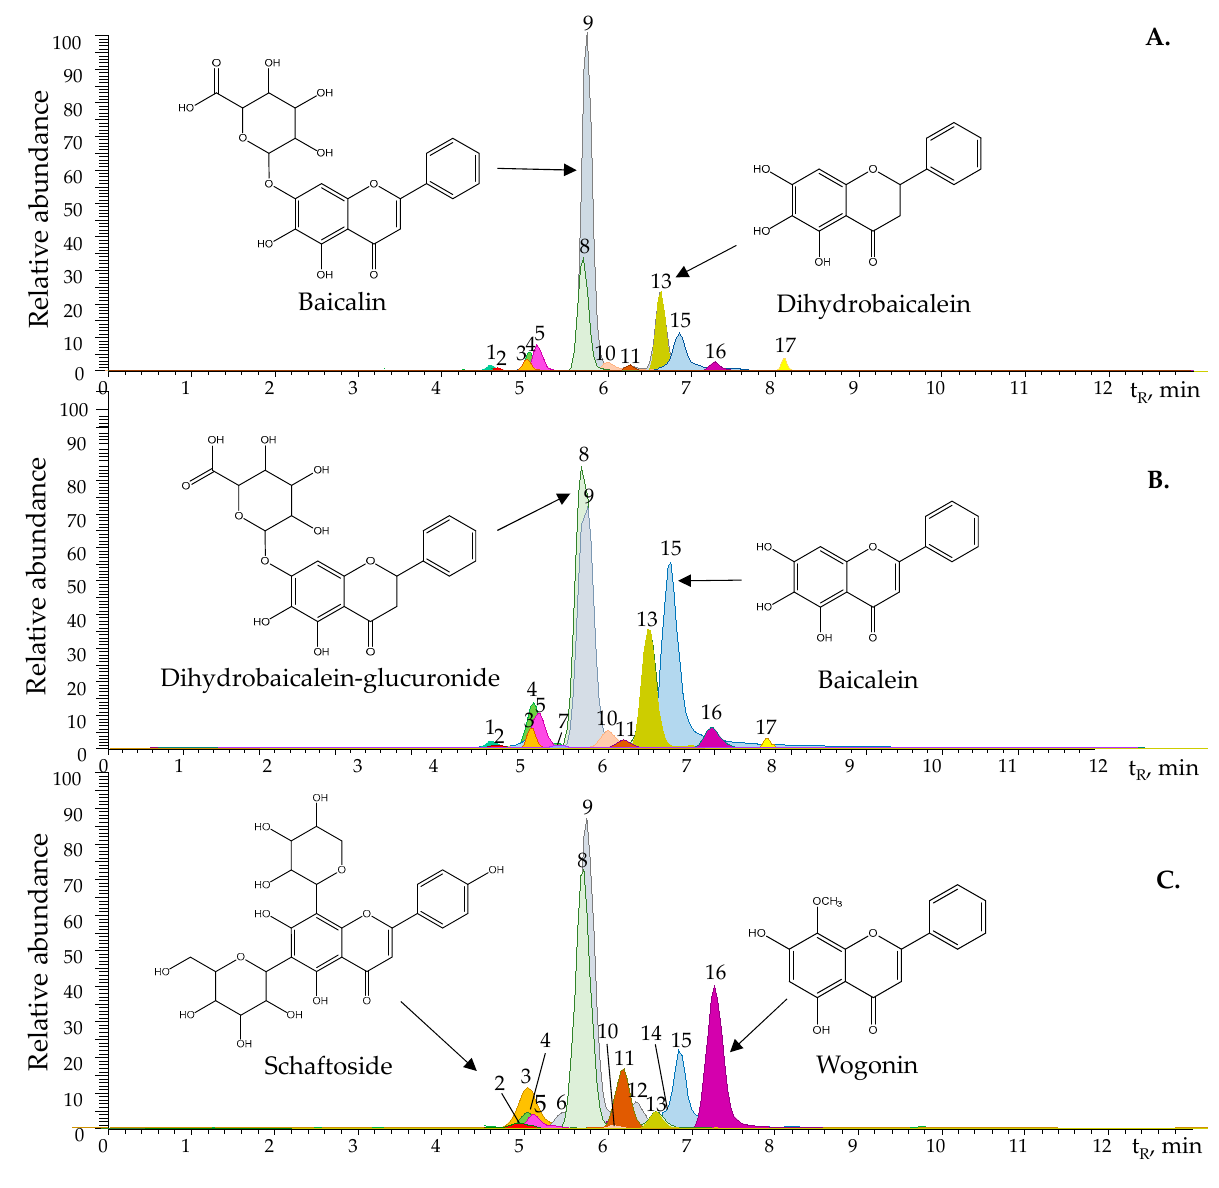
Figure 2. Extracted ion currents (EICs) obtained by UHPLC/ESI-Q- Orbitrap -MS in full scan mode of protonated molecules [M+H] + from hydroalcoholic extracts of ( A ). S. incarnata , ( B ). S. coccinea and ( C ). S. ventenatii × S. incarnata . Table 3 shows peak identi fi cation.